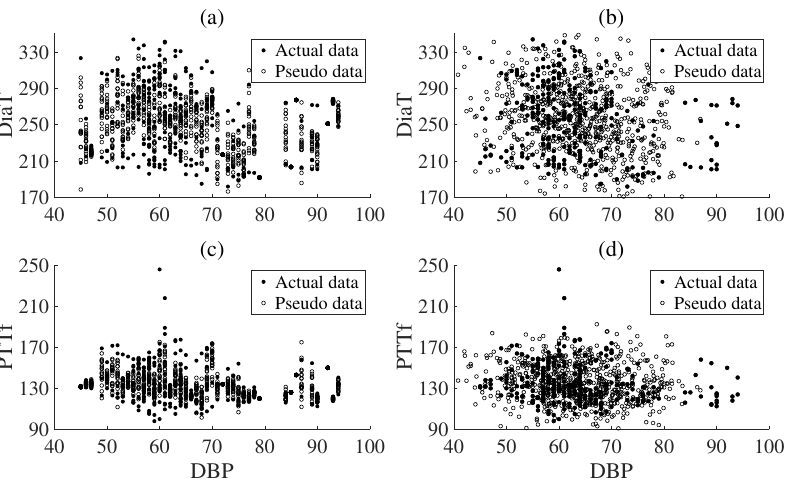
Figure 4. Data augmentation results for DiaT, PTTf and reference DBP (unit: mmHg). ( a , c ): the bootstrap algorithm, ( b , d ): the proposed algorithm.